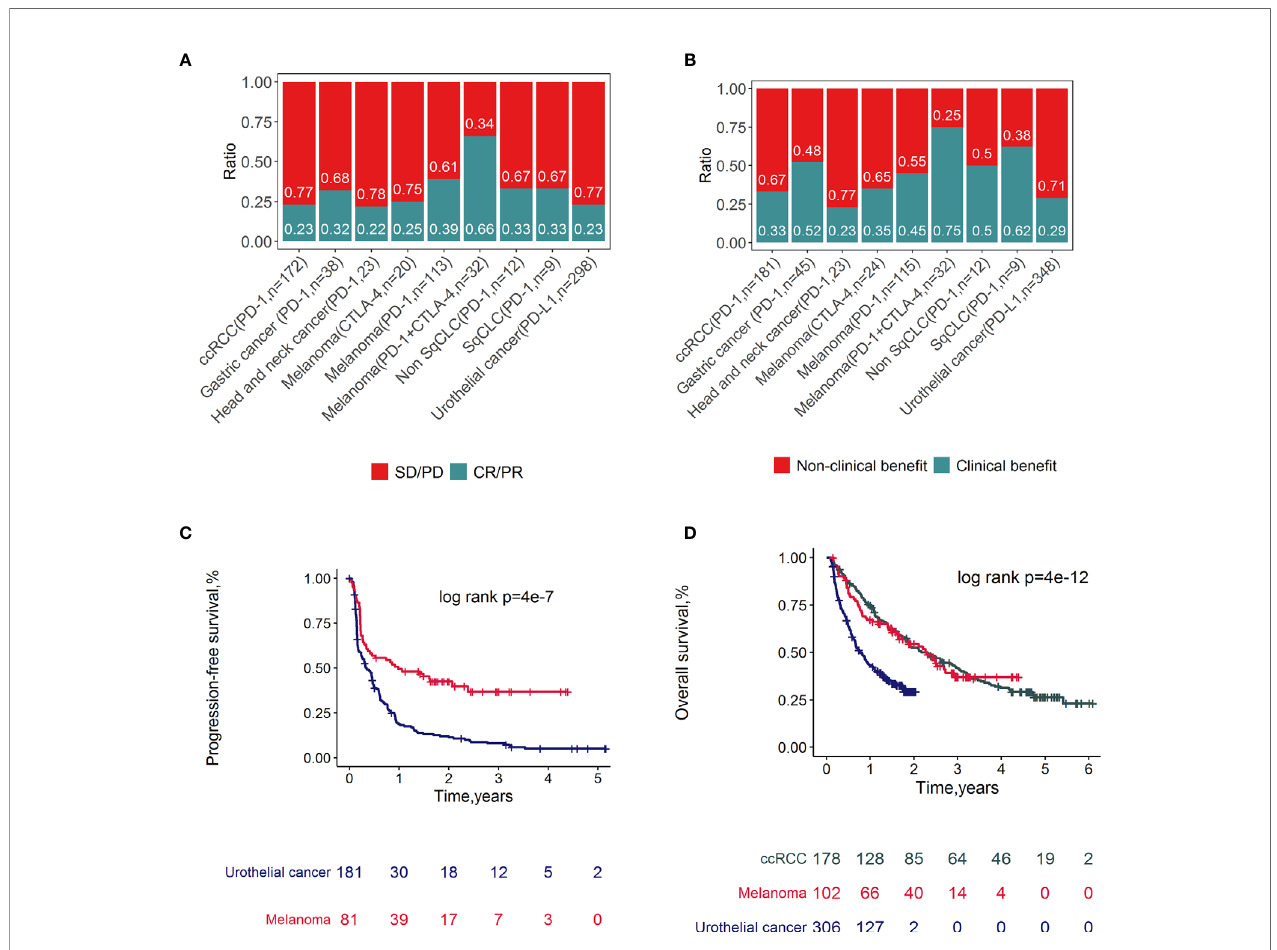
FIGURE 2 | Clinical outcomes of ICI related datasets. Spine plots for response (A) and clinical bene fi t (B) and survival plots for PFS (C) and OS (D) and by cancer types. P-values from log-rank tests are